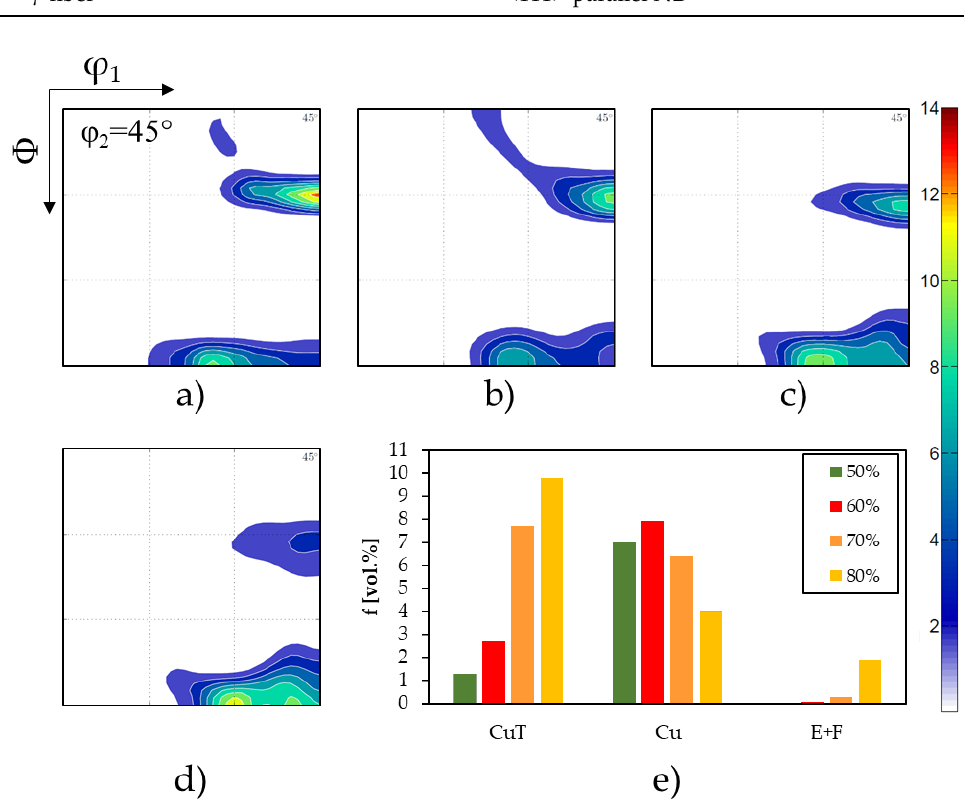
Figure 5. Texture evolution of the material rolled at 500 °C to different rolling reductions. ODF sections at φ 2 = 45° of ( a ) 50%, ( b ) 60%, ( c ) 70%, and ( d ) 80% and ( e ) presentation of the volume fractions of selected texture components.